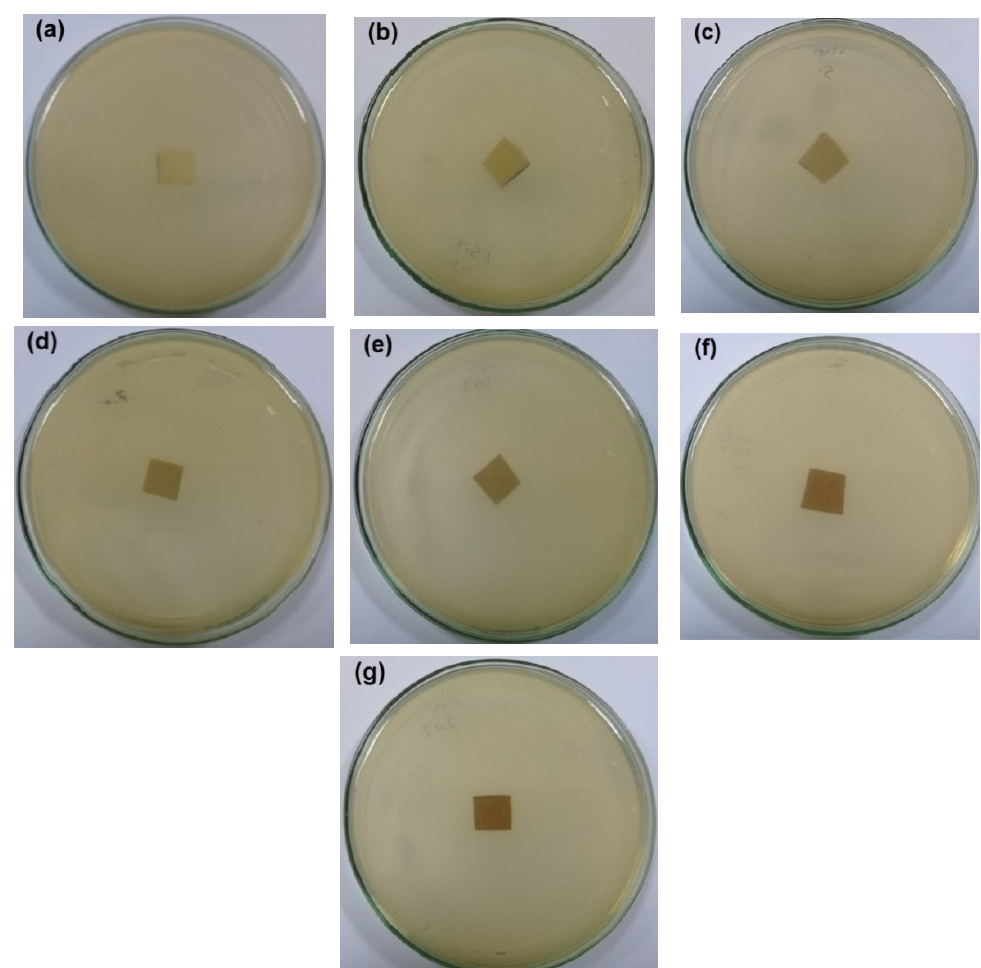
Figure 6. Images of the antibacterial test of CNFs/Pectin/PGE films against E. coli : ( a ) blank CNFs, ( b ) CNFs + 2.5% Pectin/PGE, ( c ) CNFs + 5% Pectin/PGE, ( d ) CNFs + 7.5%